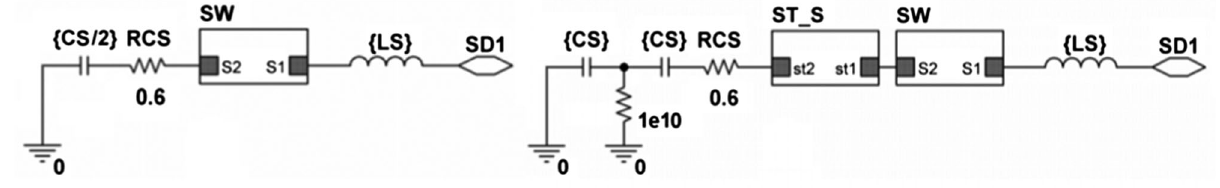
FIG. 4. The OrCAD model of the ST_S block.